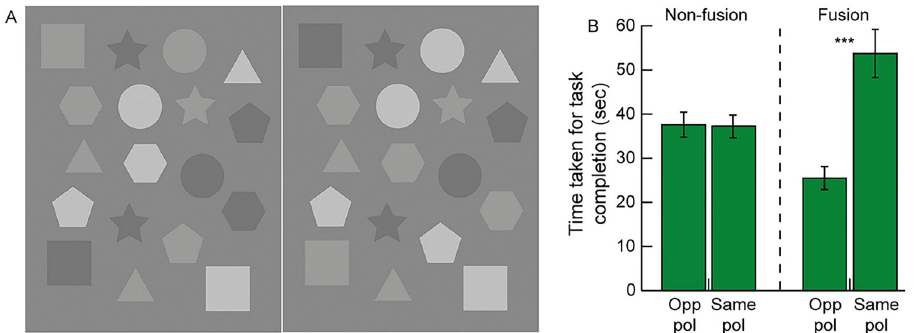
Fig 6. Sample image pair used in Experiment 4 (Panel A). This image contains difference pairs with opposite luminance polarity that is meant to enhance the experience of lustre (top left square, middle-right hexagon and bottom left square) and difference pairs with same luminance polarity that weakens the experience of lustre (top circle, middle hexagon and bottom-right hexagon). Mean ( ± 1 SEM) time to task completion for difference pairs with opposite luminance polarity (Opp pol) that enhances the experience of binocular lustre and difference pairs with same luminance polarity (Same pol) that weaken the experience of binocular lustre (Panel B). Each pair of bars show data from the non-fusion and fusion modes of gameplay. Asterisk symbols are same as Fig